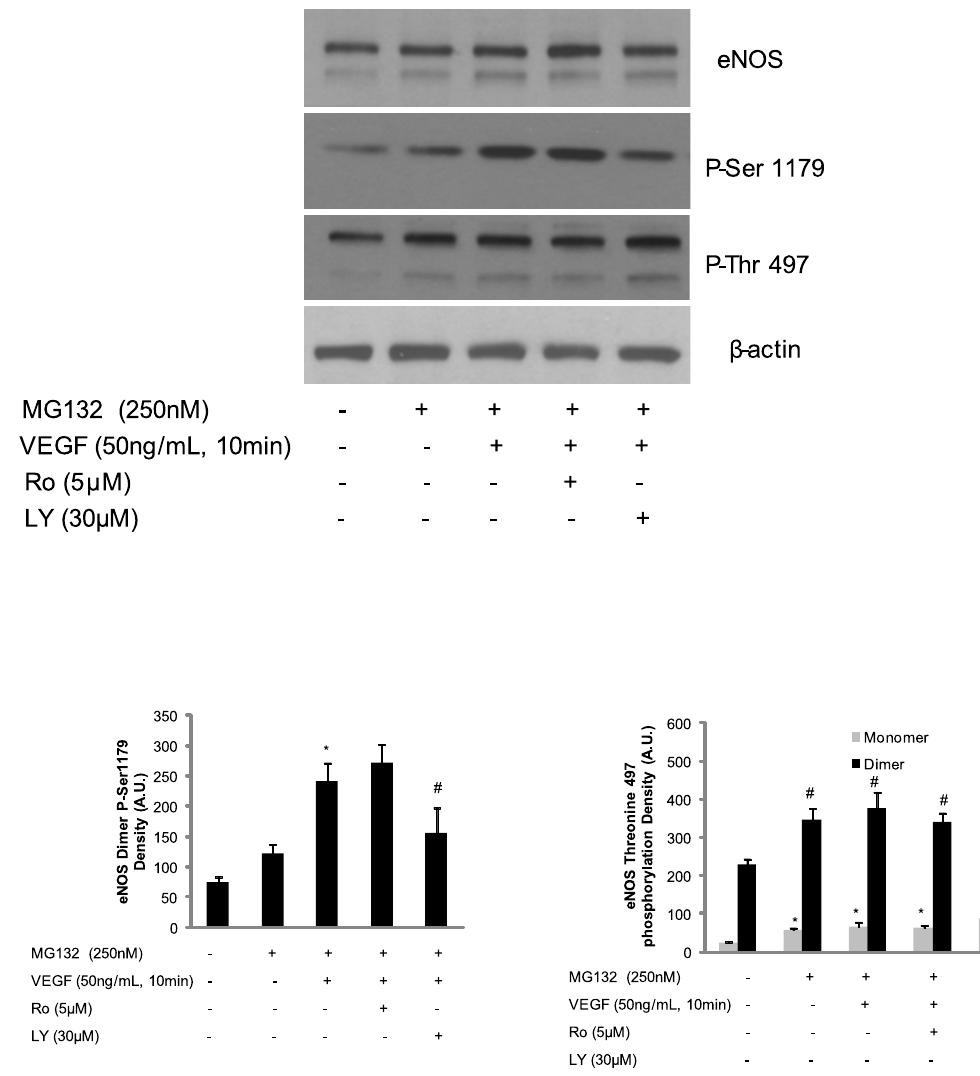
Figure 4. The PI3K signal pathway is the major pathway causing eNOS Serine 1179 phosphorylation induced by VEGF. After BAECs were treated with MG132 and Ro318220 or LY294002 overnight followed by VEGF challenge, the cell lysates were harvested for the western blotting. The eNOS Ser1179 and Thr497 phosphorylation density were determined by AlphaImager. The results are representative of three independent experiments. (*P , 0.05 by one way ANOVA for monomers relative to untreated control and # P , 0.05 by one way ANOVA for dimers relative to untreated control).